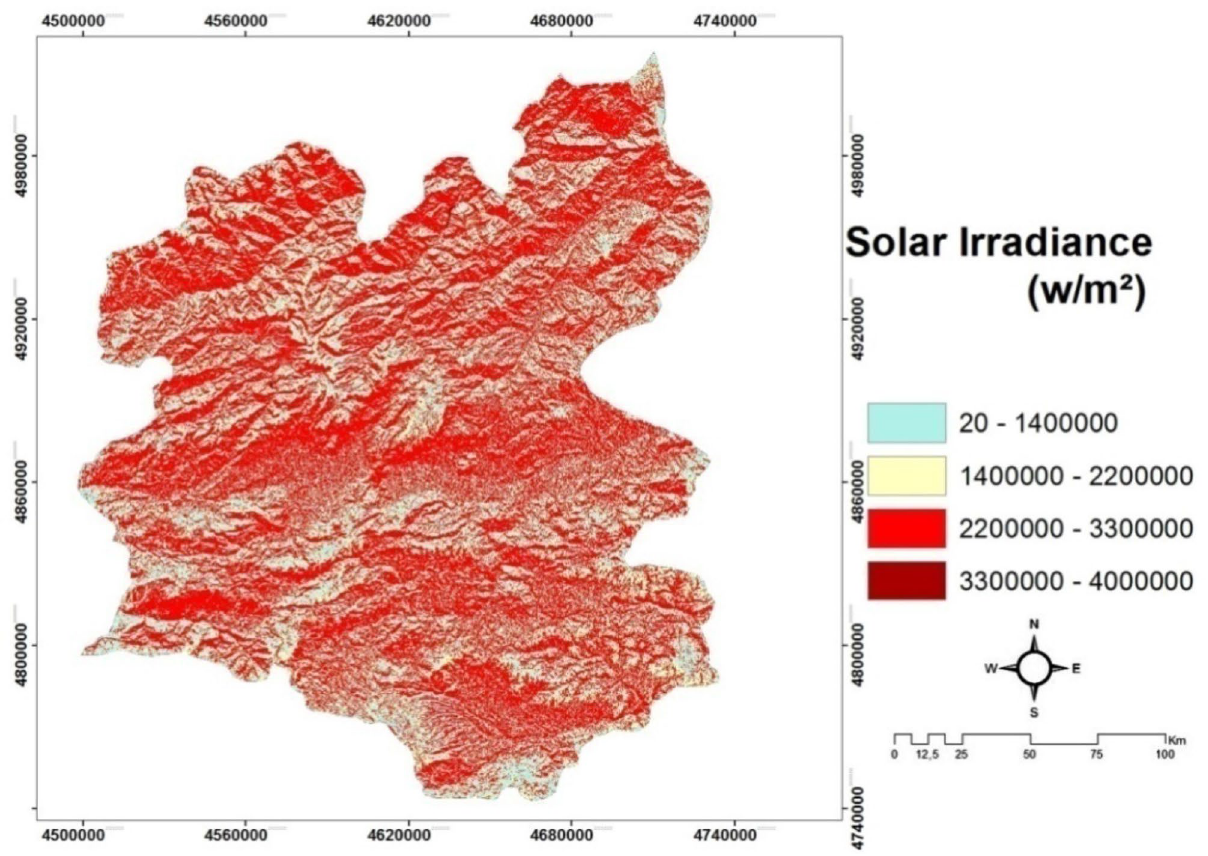
Figure 5. The map for solar irradiance in